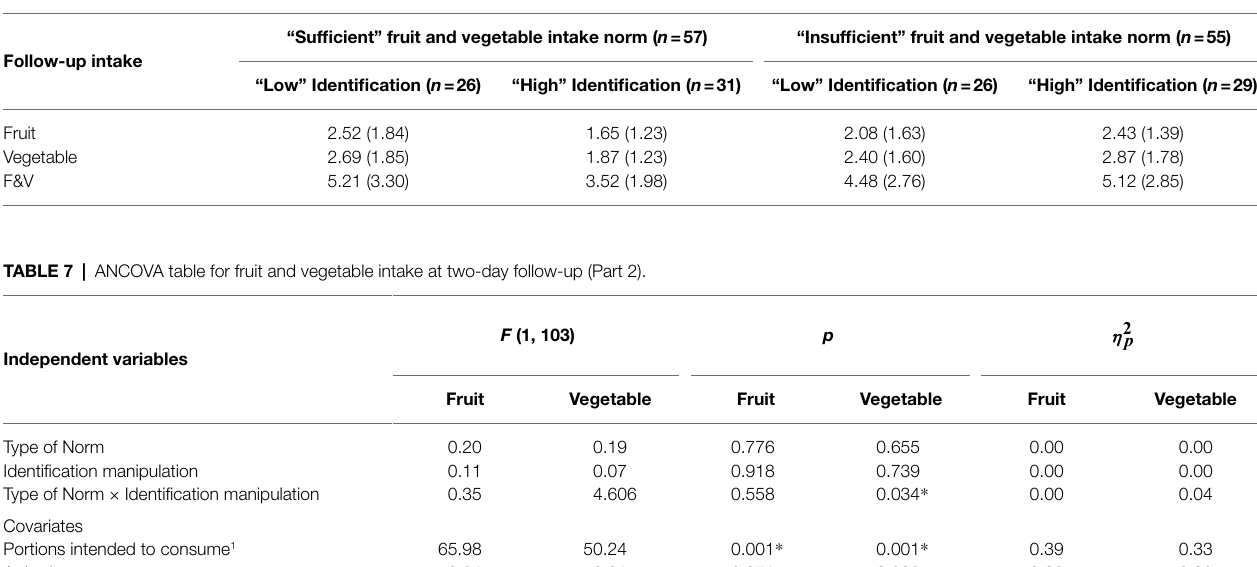
Covariates Portions intended to consume